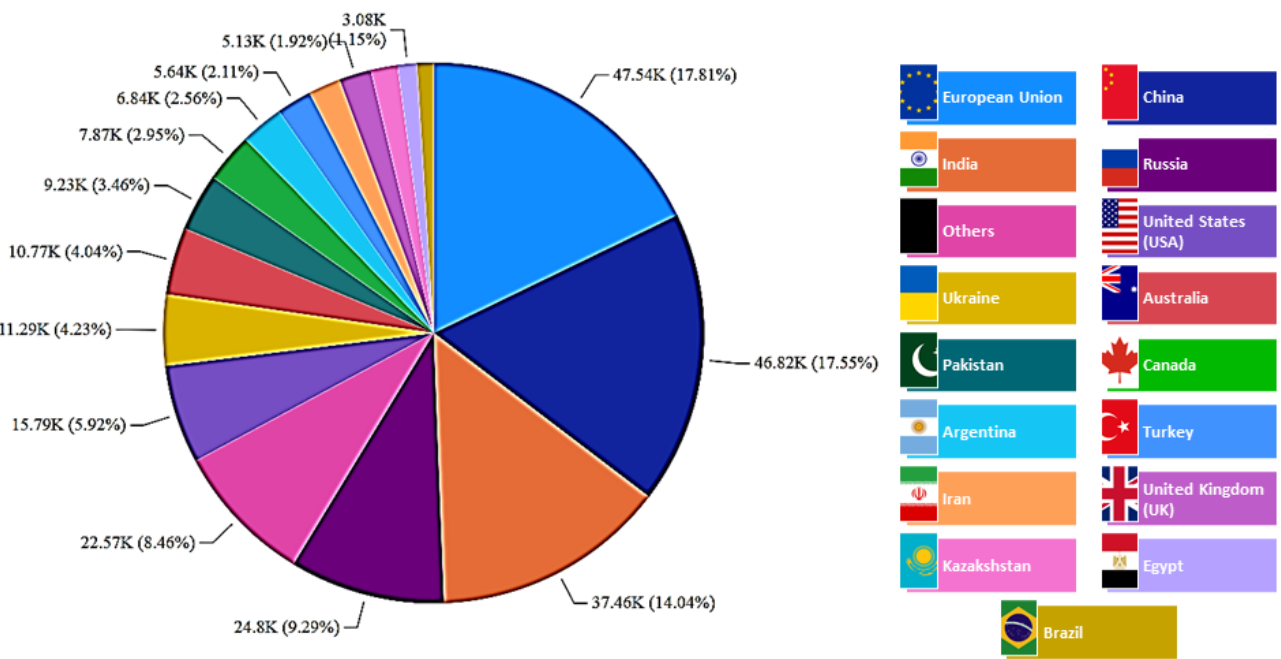
Figure 8. World distribution of cellulosic waste production from wheat (thousand metric tons).